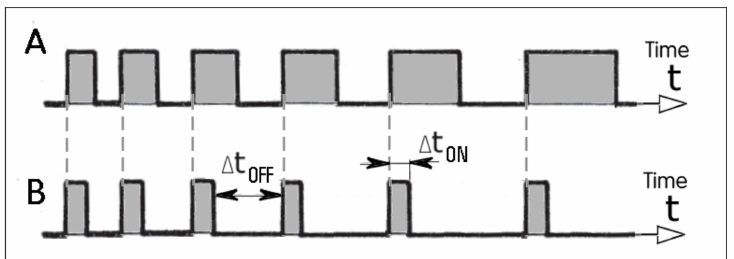
Figure 2. Examples of signal encoded in properties of rectangular flow pulses. ( A ) Pulse width modulation with a constant relative value of duty cycle ∆ t ON / ∆ t OFF. ( B ) Signal encoded in the frequency of constant-width pulses.